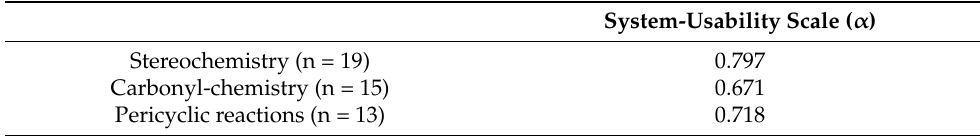
Table 2. Reliability analysis of the System-usability